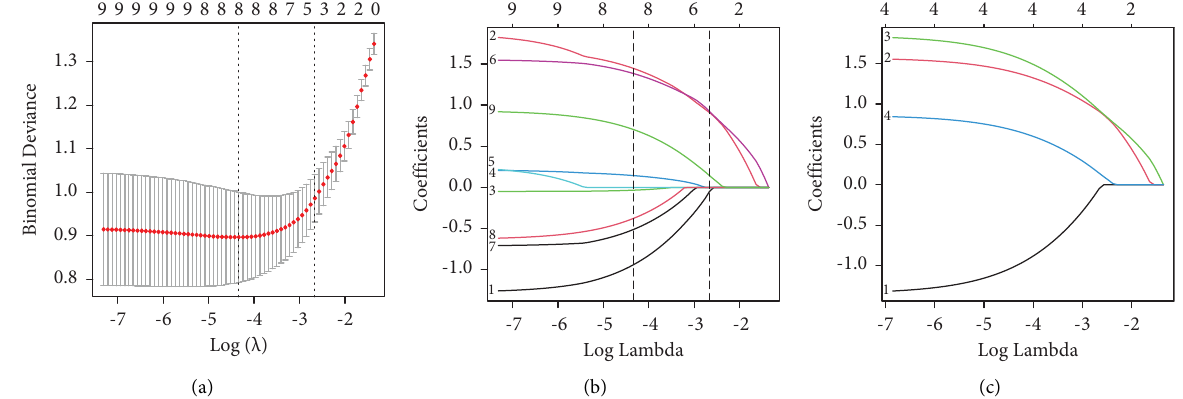
Figure 2: Te optimal parameters of the LASSO, with an optimal λ of 0.06974 and log ( λ ) of − 2.662981, resulting in the reduction of 9 features to 4 (a). (b, c) present the four variables with nonzero coefcients: the type of AR, comorbidities, family history of AR, and the duration of